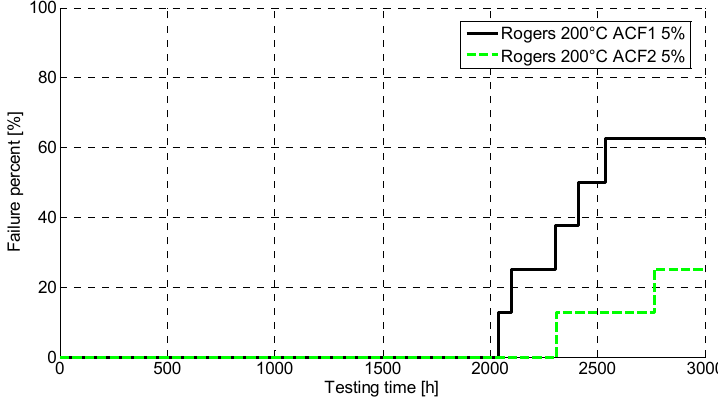
Figure 7. CDF for Rogers at 200 °C.